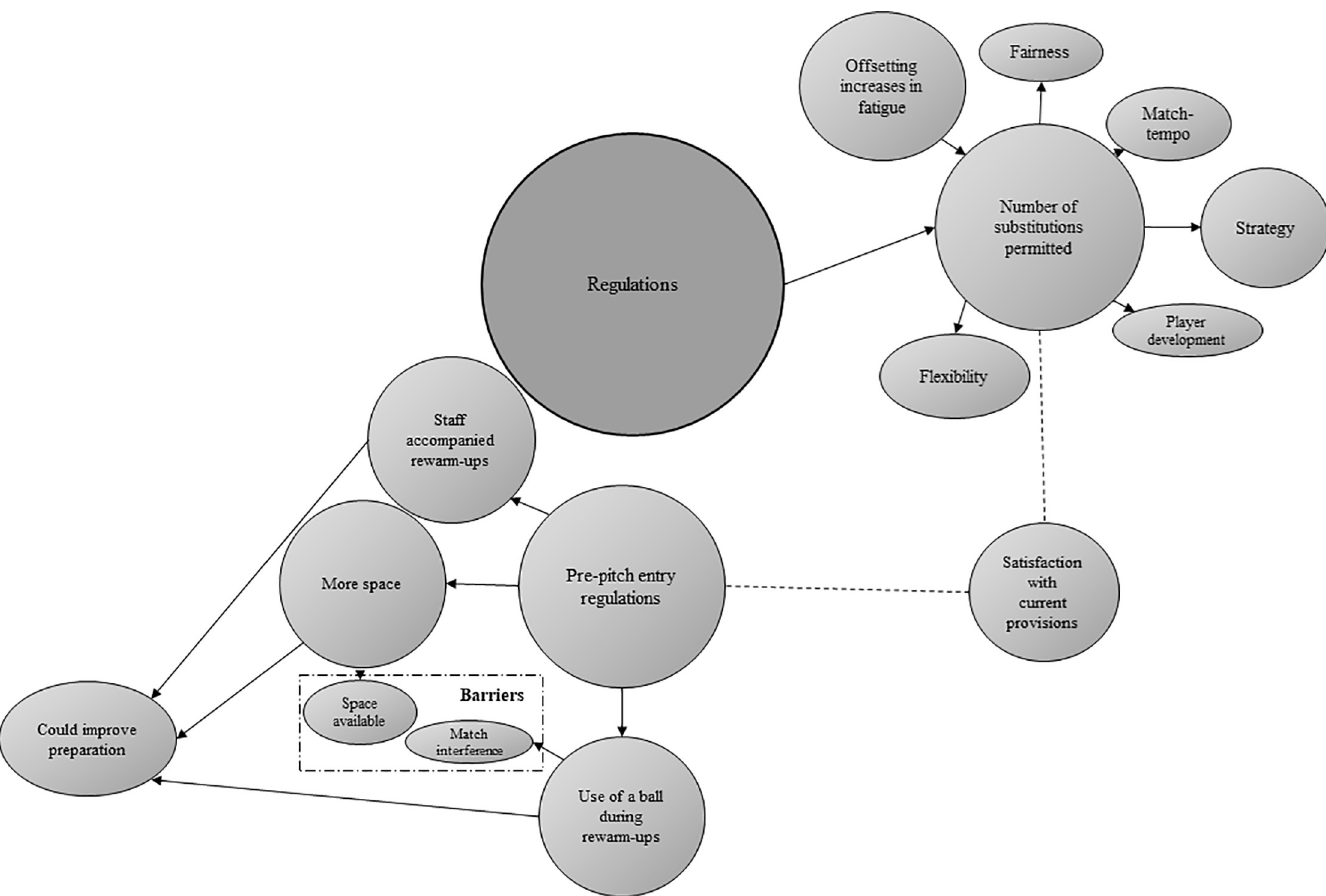
Fig 4. Thematic emergences depicting practitioner responses concerning current regulations (n = 33). Prevalence is indicated by size.